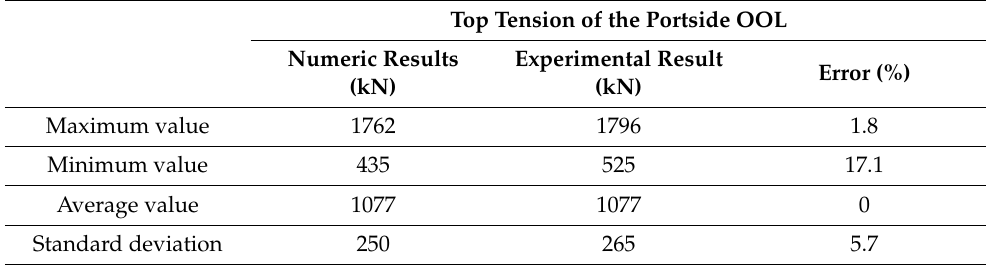
Figure 9. Top tension of the portside OOL. Table 7. Comparison of experimental and numerical simulation results of OOL p top